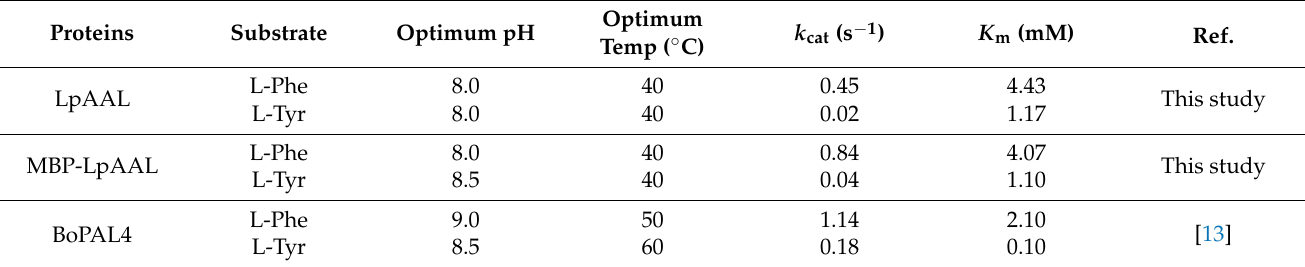
Table 3. Comparison of biochemical properties and kinetic parameters of PAL and TAL activities in LpAAL, MBP-LpAAL, and BoPAL4